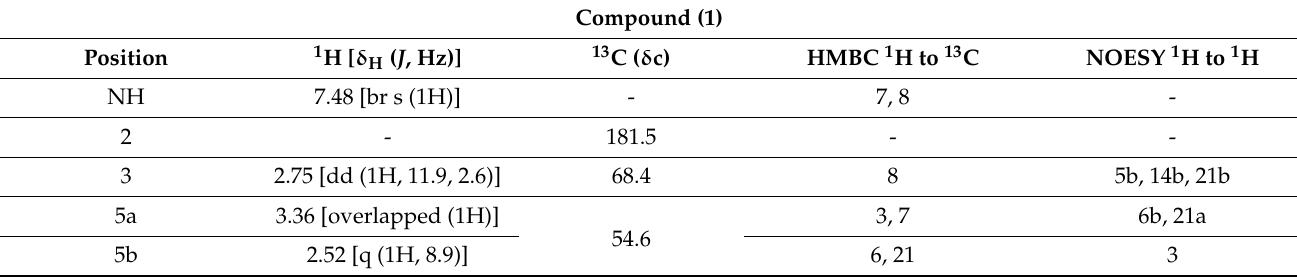
Table 1. 1D and 2D NMR data of compound ( 1